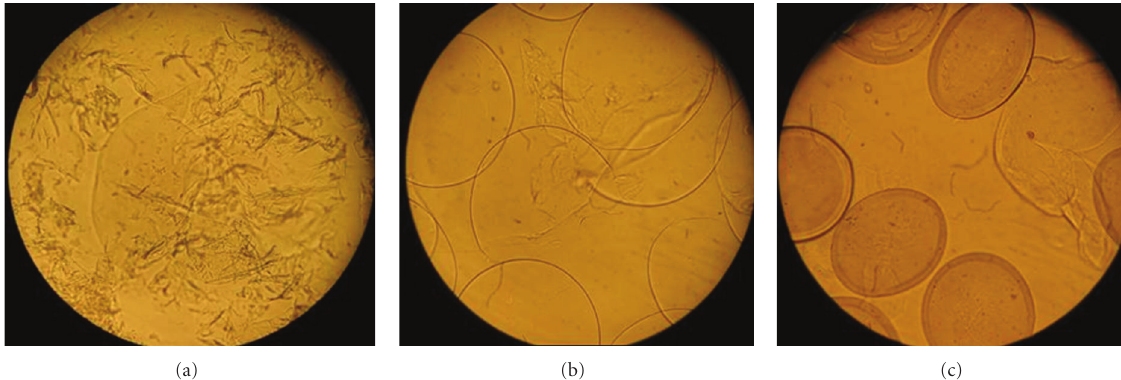
Figure 7: Microphotographs of APA (a), AC (b), and GCAC (c) microcapsules after being subjected to mechanical agitation (600rpm) for 3 hours. Original magnifications: 90 × .